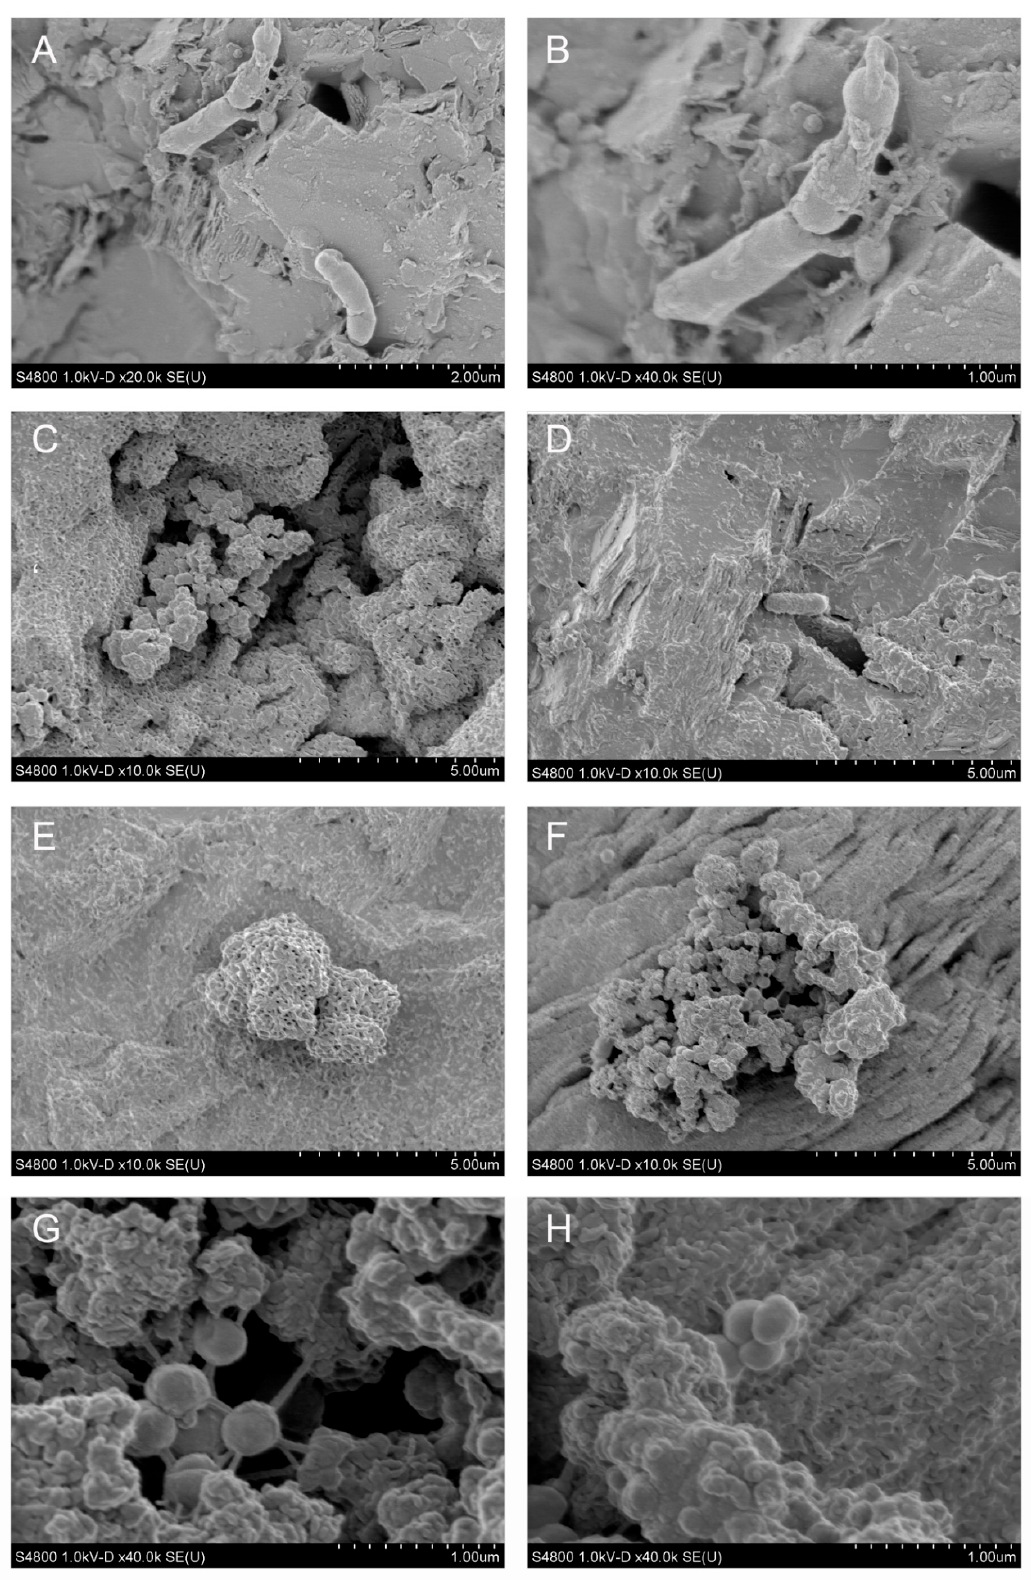
Figure 3. SEM analysis of the in situ incubated mica schist surfaces from the closed trap model ( A , B ) and open trap model ( C – H ) from the depth of 967 m. Each figure has a scale at the bottom for size reference (um = µm). ( A ) Potential bacterial cells with extracellular excretions, ( B ) close-up of ( A ), ( C ) biofilm-like structures on rock surface, ( D ) cell-like structure, ( E ) small spheroid structures, ( F ) consortia of assumed small-sized cells showing nanotube-like filamentous intercellular structures ( G ), and coccoid attached cell-like-clusters ( H